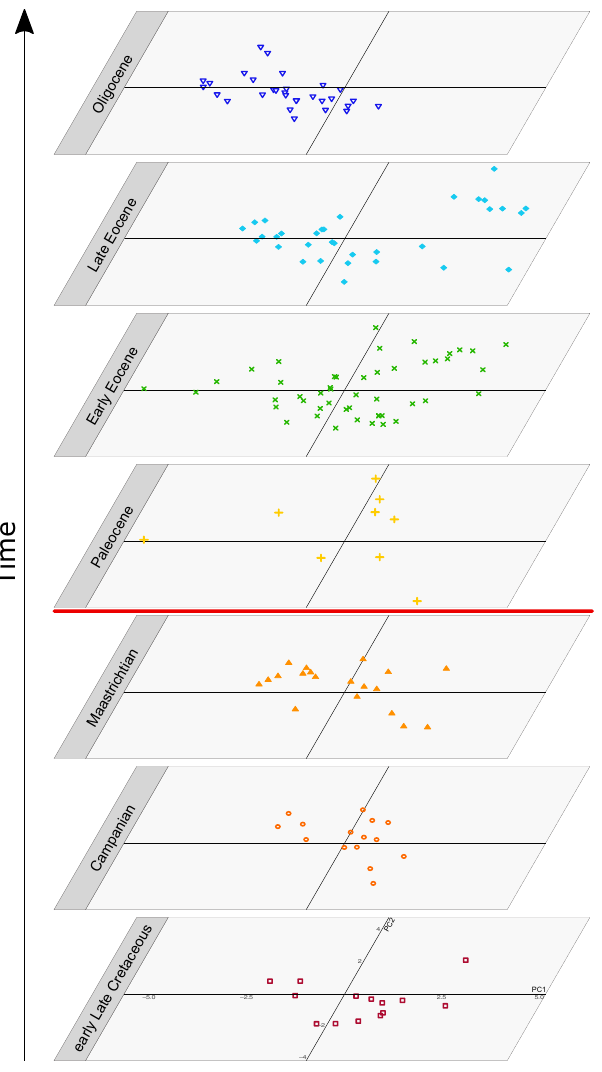
Fig. 2 Principal component analysis of vertebral shape across different time bins, based on nine measurements, corrected for size. The K-Pg boundary is indicated by a red